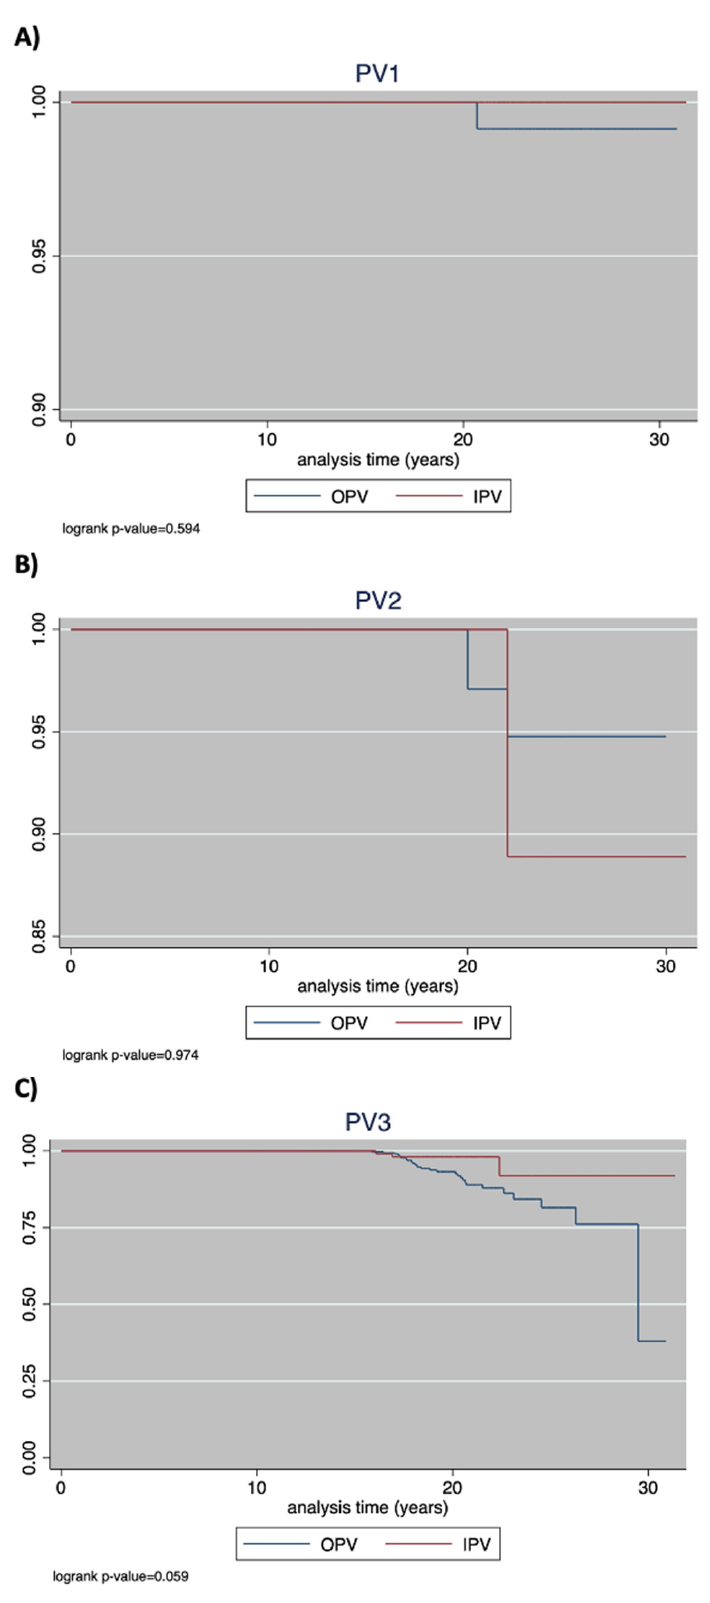
Figure 3. Kaplan–Meier estimates of protective antibody survival, per group (IPV vs. OPV) for ( A ) PV1, ( B ) PV2, and ( C )